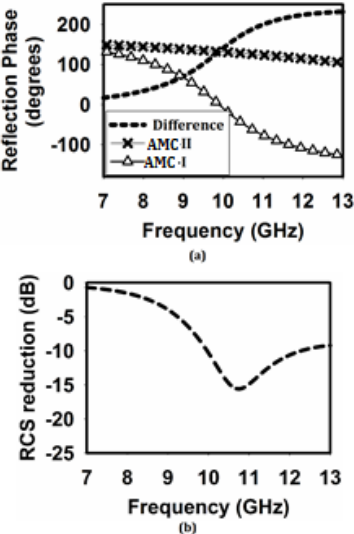
Figure.7. Simulated response from chessboard structure with AMC ground plane (a) Reflection phase characteristics (b) calculated RCS reduction